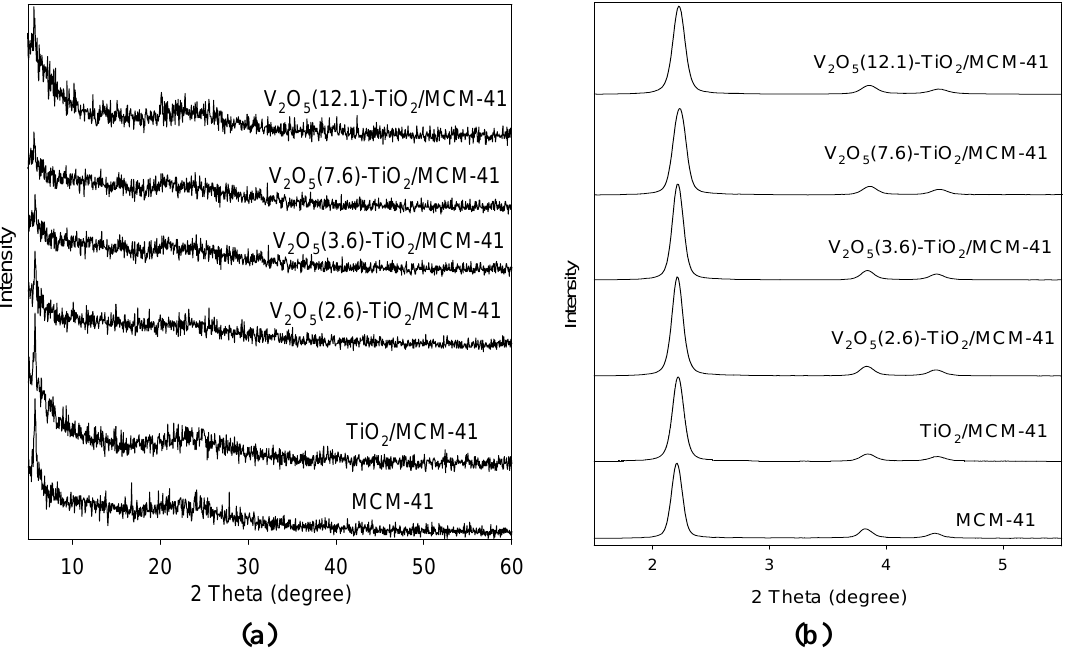
Figure 1. XRD patterns of various catalysts ( a ) low angle XRD; ( b ) high angle XRD.